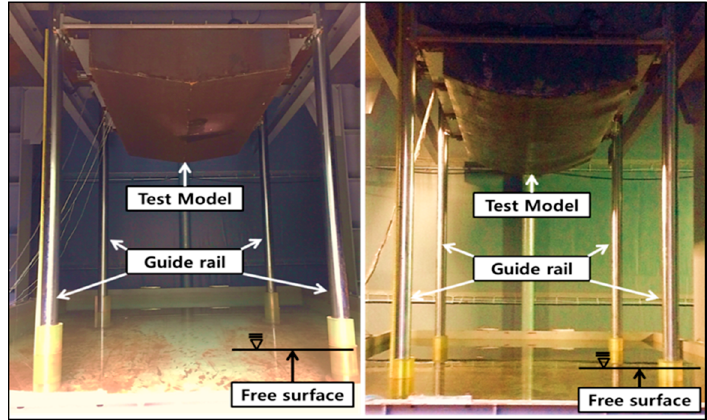
Figure 3. Installed model with deadrise angle of 10 ◦ ( left ) and cylindrical model ( right ) in slamming test system.